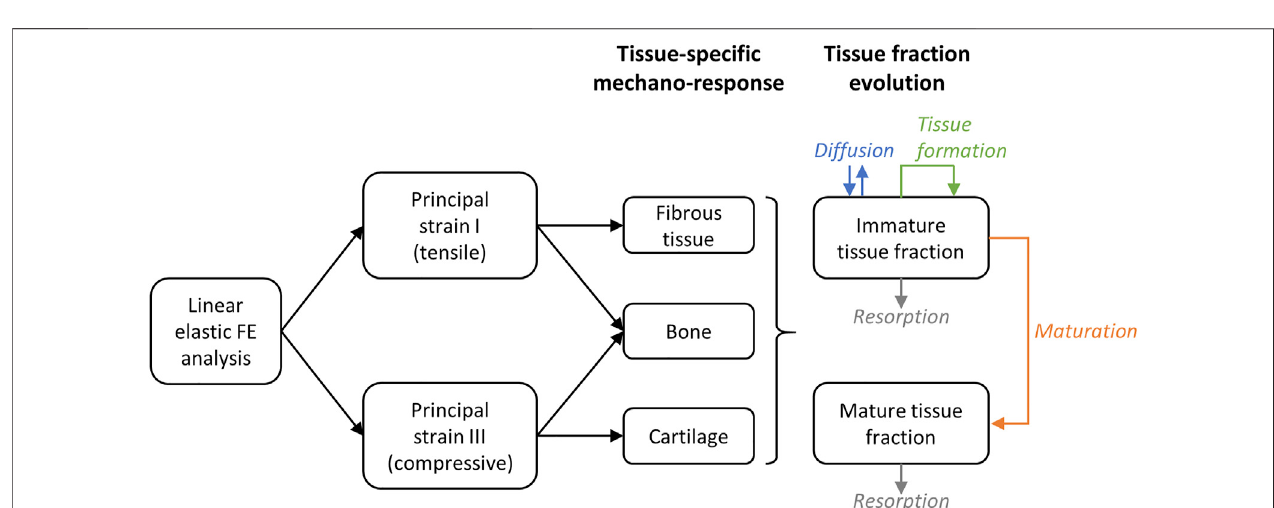
FIGURE 1 | Principle of the mechano-sensing and tissue fraction evolution simulation. On the right (tissue fraction evolution), the direction of the arrow indicates if the contribution is positive (arrow pointing towards the box) or negative (arrow pointing away from the box).